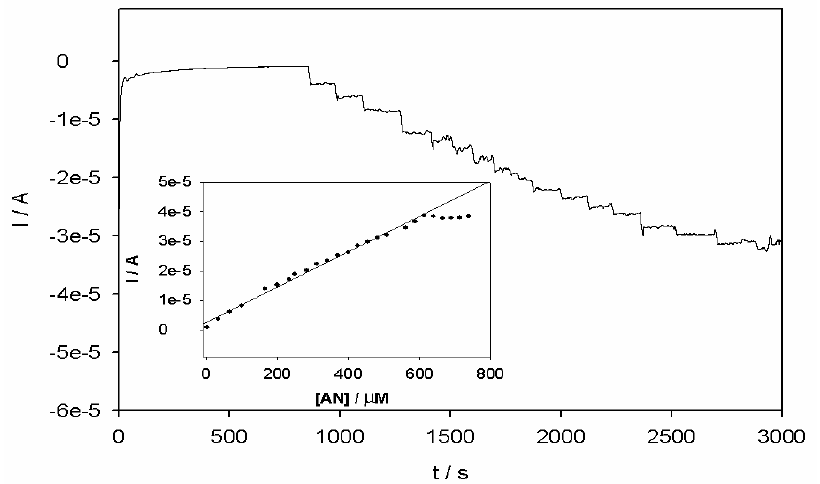
Figure 11. Current-time plot for the steady state response of the PPyox/Ag-AuNPs/GCE upon the successive addition of 3.0 μ M anthracene at 1,181 mV. The measurements were carried out in a continuously stirred acetonitrile solution of LiClO shows a calibration plot of current against